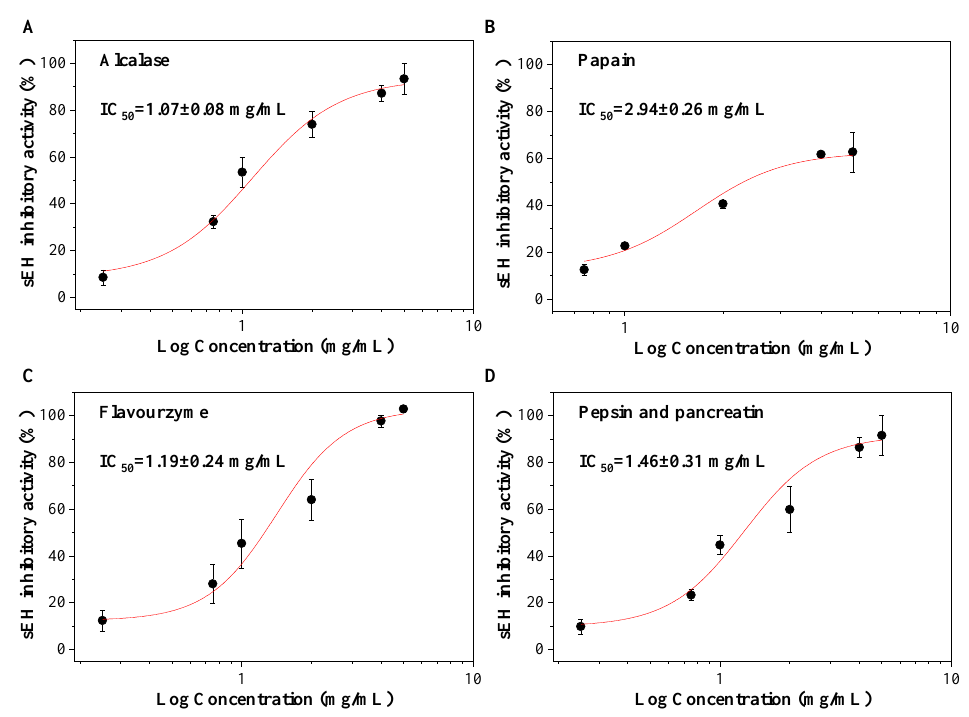
Figure 5. The sEH inhibitory activities of corn gluten hydrolysates by Alcalase ( A ), papain ( B ), Flavourzyme ( C ), and pepsin and pancreatin ( D ).